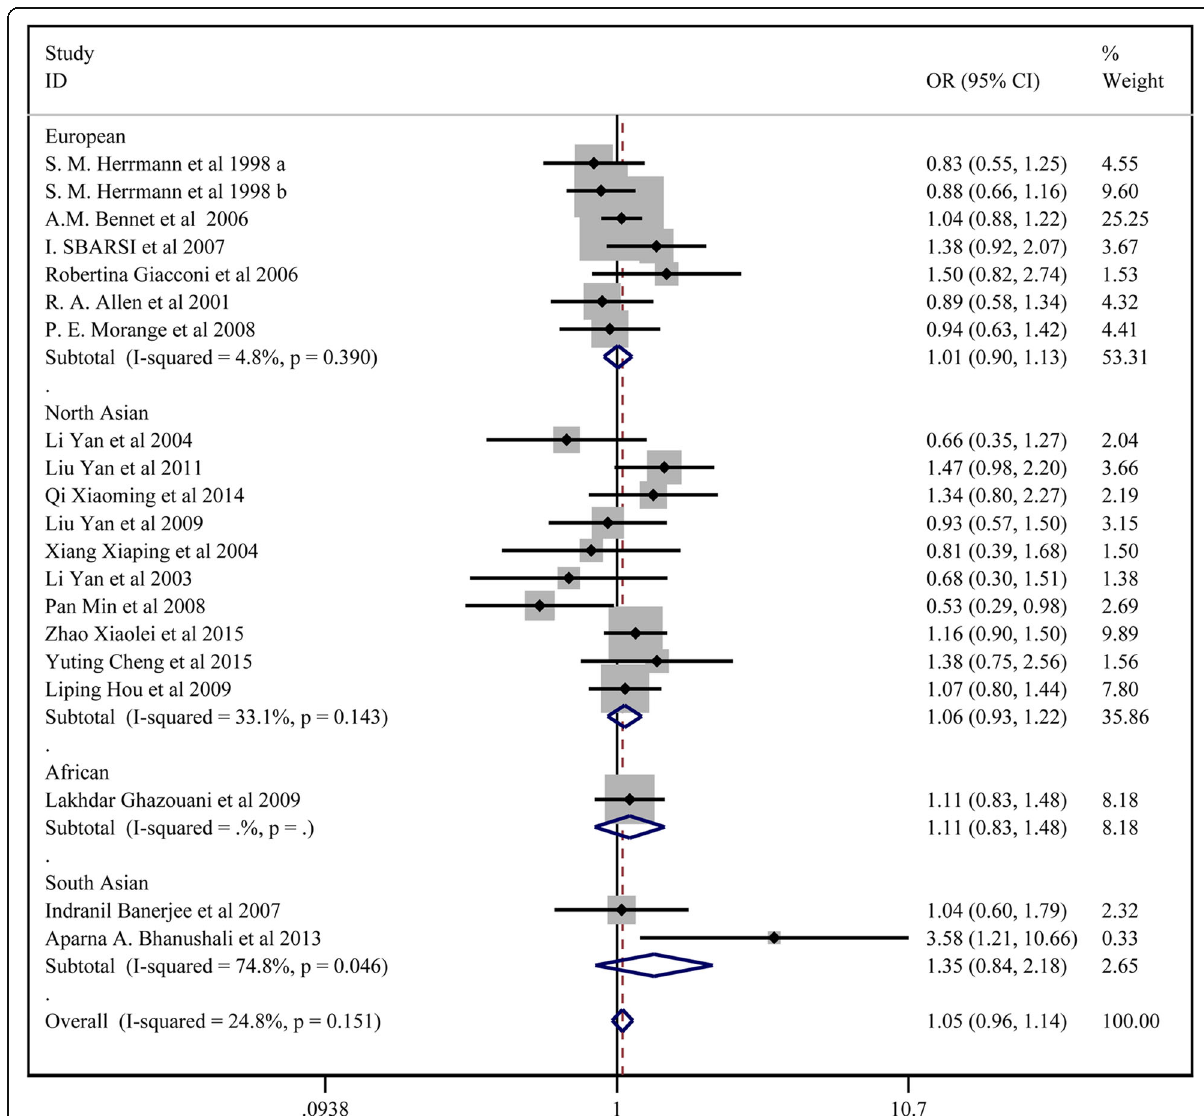
Fig. 3 Forest plot for the dominant model of TNF- α 308G/A polymorphisms associated with